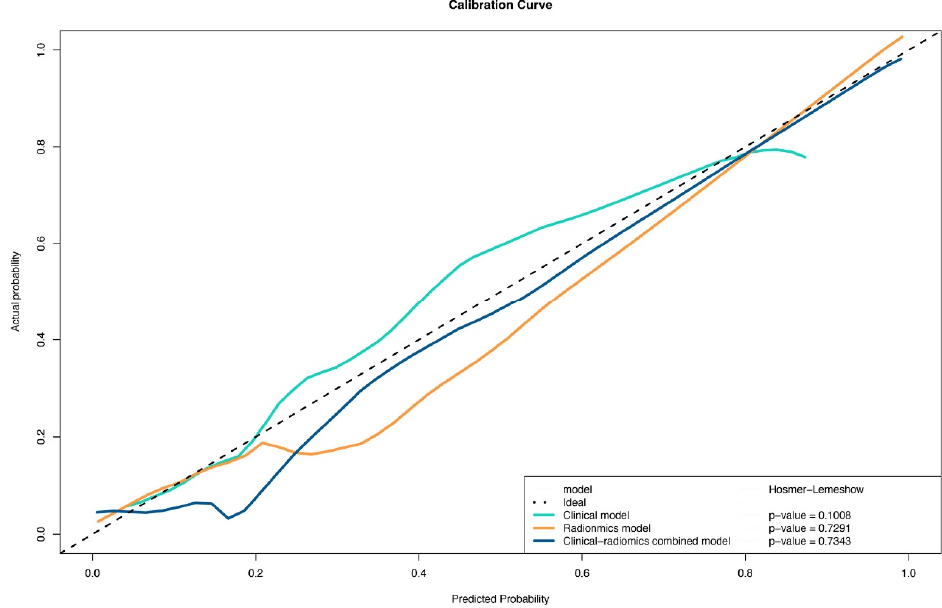
Figure 6. Calibration curve of the radiomics nomogram for predicting PCa in the validation cohort.